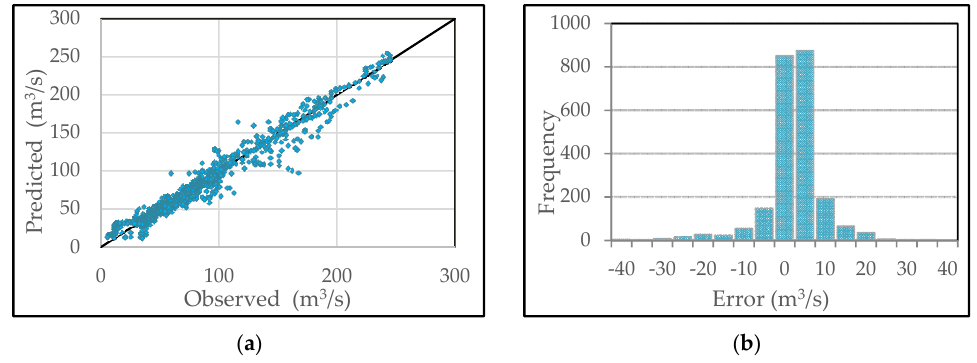
Figure 6. ( a ) Flow forecasts vs measured flows at the Graus station. ( b ) Empirical frequency distribution of the errors (validation data set).